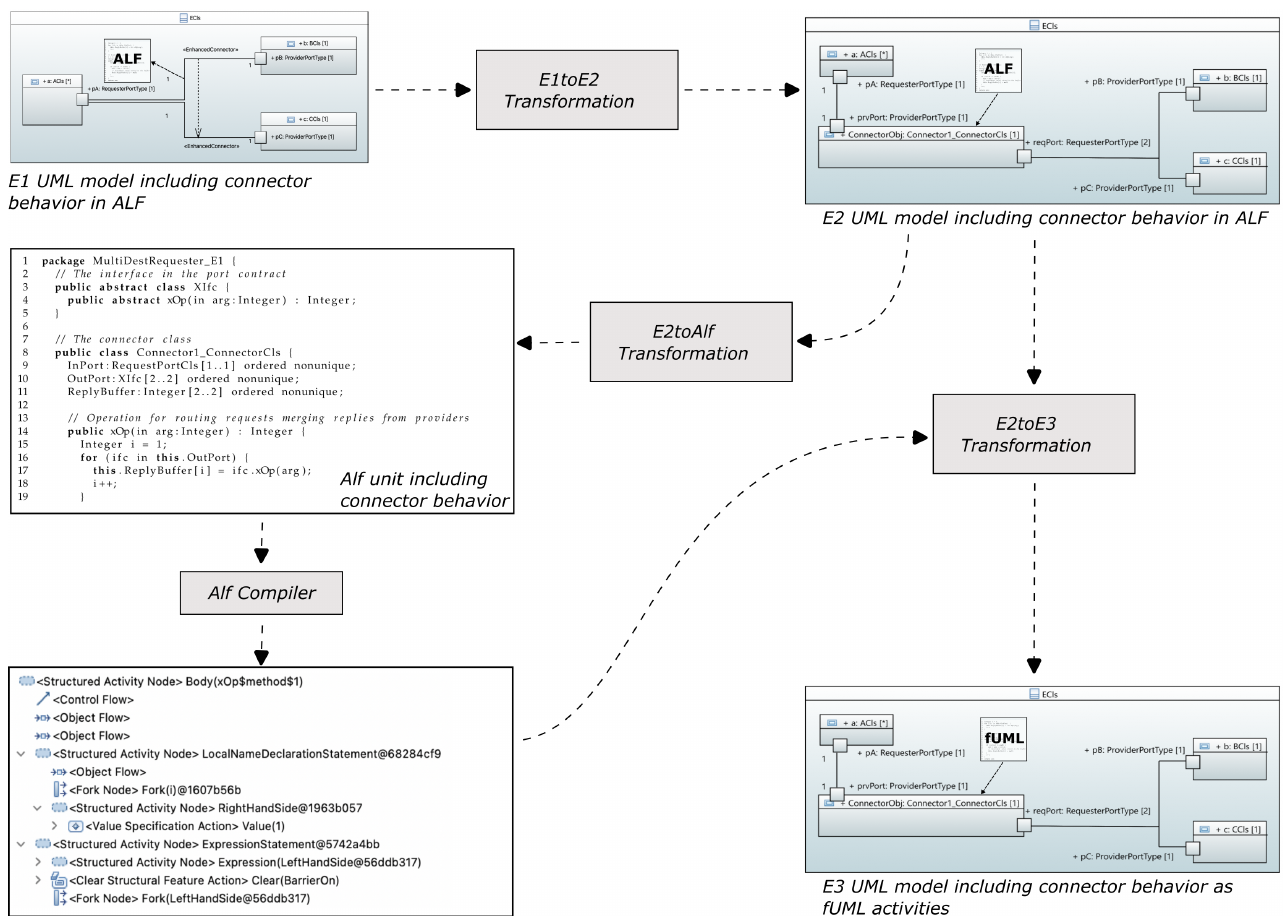
Figure 10. Enhanced connector transformation